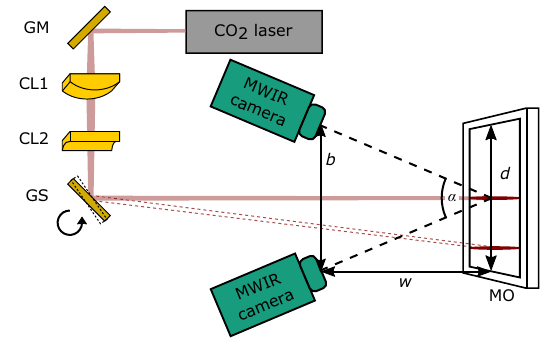
Figure 1. Schematic setup of our MWIR 3D system based on sequential thermal fringe projection consisting of projection unit (CO 2 laser, gold mirror GM, ZnSe lenses CL1 and CL2, gal- vanometer scanner equipped with gold mirror GS), measurement object MO, and MWIR